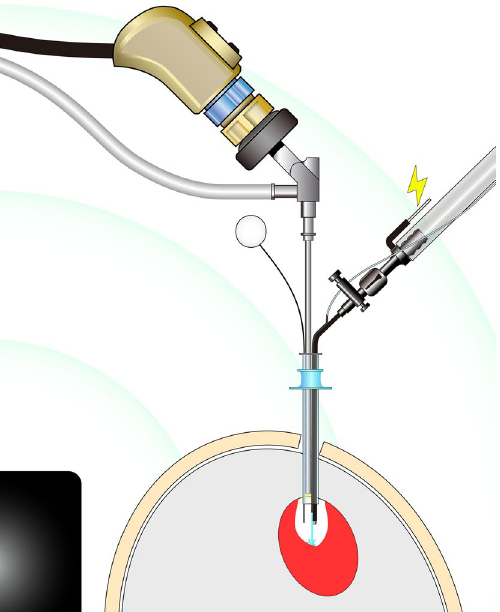
Figure 1. Schematic illustration of the endoscopic hematoma removal using the combined irrigation- coagulation suction cannula through the Neuroport, transparent sheath with the help of the electromagnetic neuronavigation. The multifunction cannula releases water from its tip for irrigation and is covered with a black electrical insulator, except for its tip and its proximal conductive part. This enables the cannula to coagulate the bleeding point at its tip by electrocoagulation supplied using a monopolar electro-cauterizer. The electromagnetic neuronavigation allows for frameless, pinless image-guided endoscopic hematoma removal under local anesthesia. The black object is the electromagnetic field emitter, and the green arcs imitate the electromagnetic field. The electromagnetic flexible navigation pointer is inserted through the NeuroPort and identifies the area that we are endoscopically